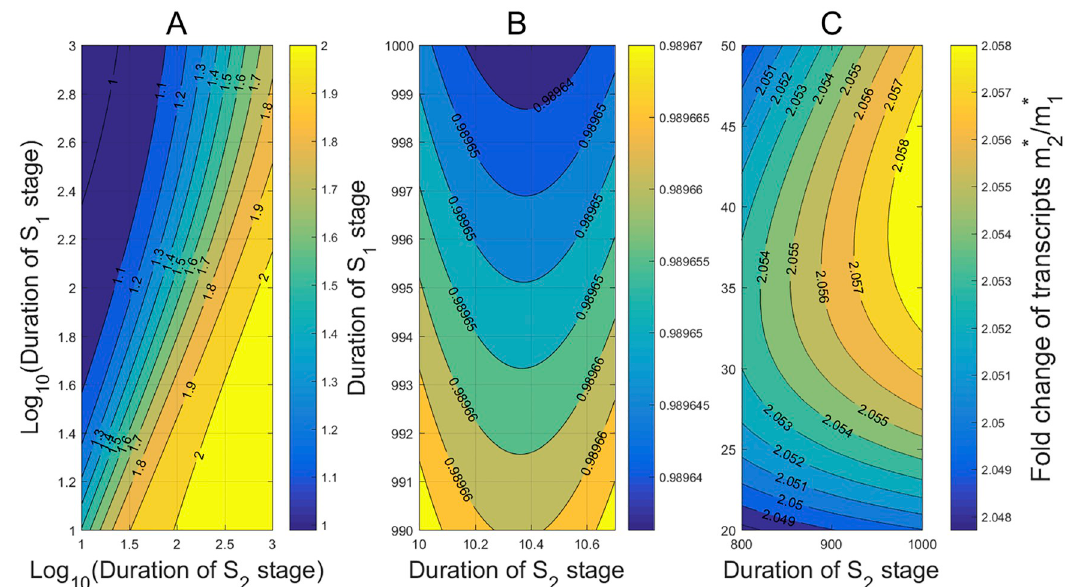
Fig 2. The condensation of r � within [1, 2] and its dependance on the stage durations. All kinetic rates are estimated from [15] in the transcription of Oct 4 gene in mouse embryonic stem cells. (A) For almost all the S 000 min, r � is within a narrow range [1, 2]. When 1/ κ 1 � 1/ κ 2 (or 1/ κ 1 � 1/ κ 2 ), r � varies slowly over a narrow region around 1 (or 2). When the two durations are close, r � changes rapidly over (1.1, 2). (B) When the S duration, r � < 1 and is very close to 1. (C) When the S close to